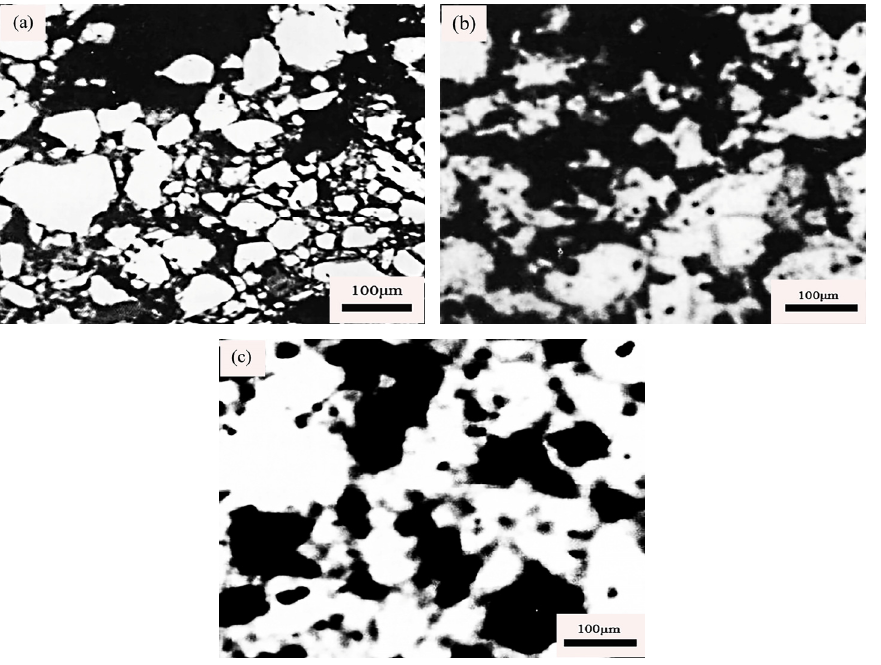
Figure 10. Internal grain microstructure of fired pellets: ( a ) individual primary crystals; ( b ) developing crystals; ( c ) interconnecting crystals [107,108].